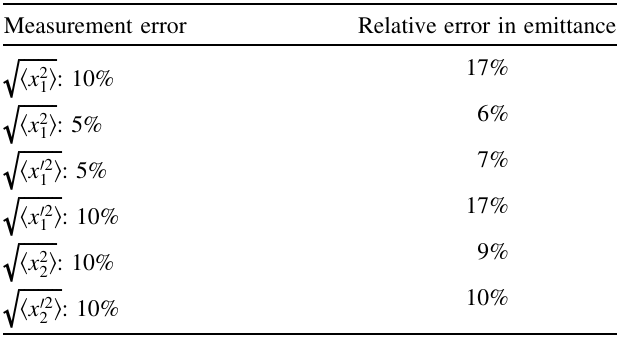
TABLE I. Errors in emittance with respect to beam measure- ment errors for the high space-charge beam ( K ¼ 7 : 02 (cid:3) 10 (cid:1) 4 ). Beam samples are taken at focal lengths f 1 ¼ 93 mm and f 2 ¼ 116 mm .